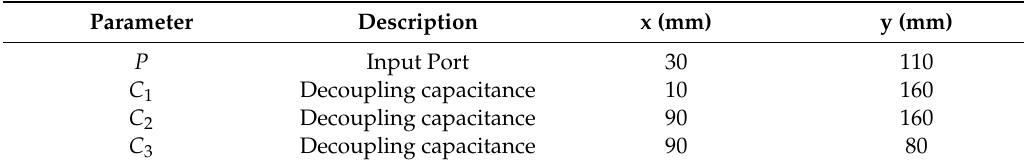
Table 1. Coordinates of the input port P and the three decoupling capacitors ( C 1 , C 2 , C 3 ). Figure 1. ( a ) Test boards and ( b ) its stack-up. The red circle represents the input port P from which